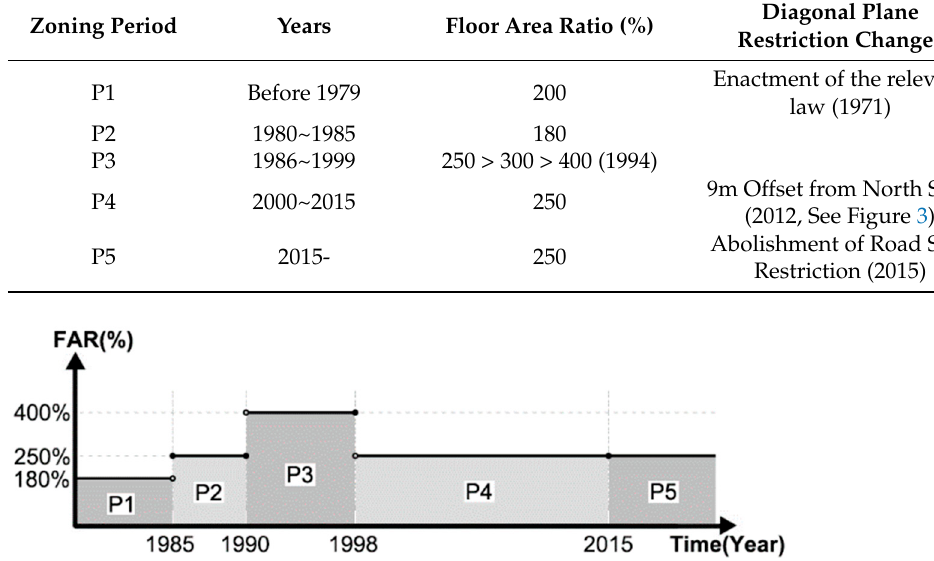
Figure 13. FAR changes with zoning period.